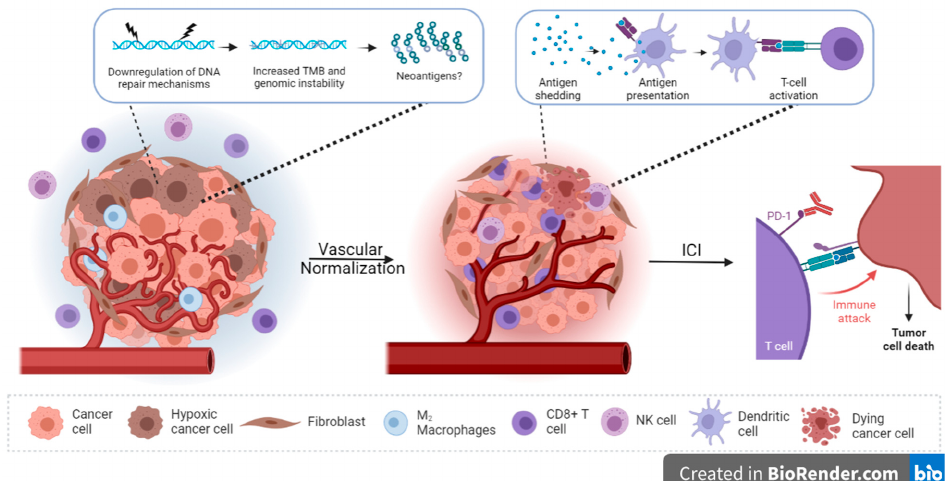
Figure 2. Vascular normalization to restore the anti-tumor immune response in PDAC. Vascular normalization is expected to reverse the immunosuppressive tumor microenvironment, thus enabling response to immune checkpoint inhibitors (ICIs). In addition, the effect of hypoxia on increased tumor mutational burden (TMB) and genomic instability could potentially increase the production of neoantigens. The uptake of such foreign antigens and their presentation to T cells could then enable tumor-cell